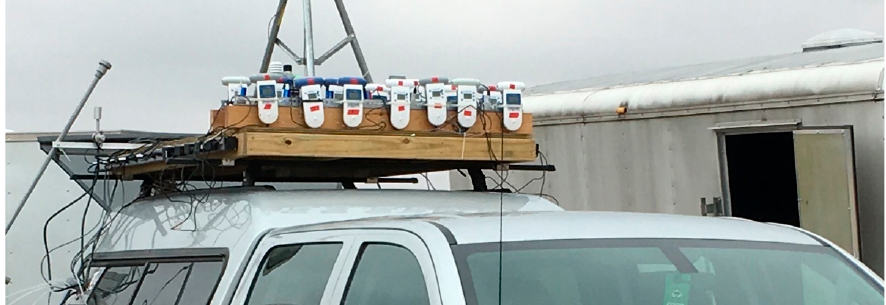
Figure 2. Photograph of Aeroqual and Cairpol sensors attached to the roof of the sampling vehicle from the November 2017 Konza and Tallgrass studies.